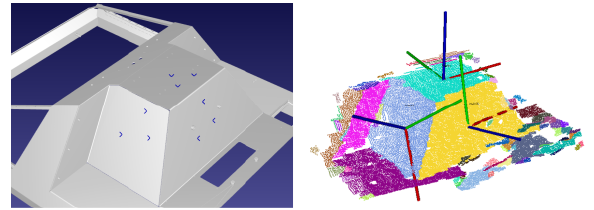
Figure 8: Gathering reference (on the left) and corresponding mea- sured surface points and normals [12]